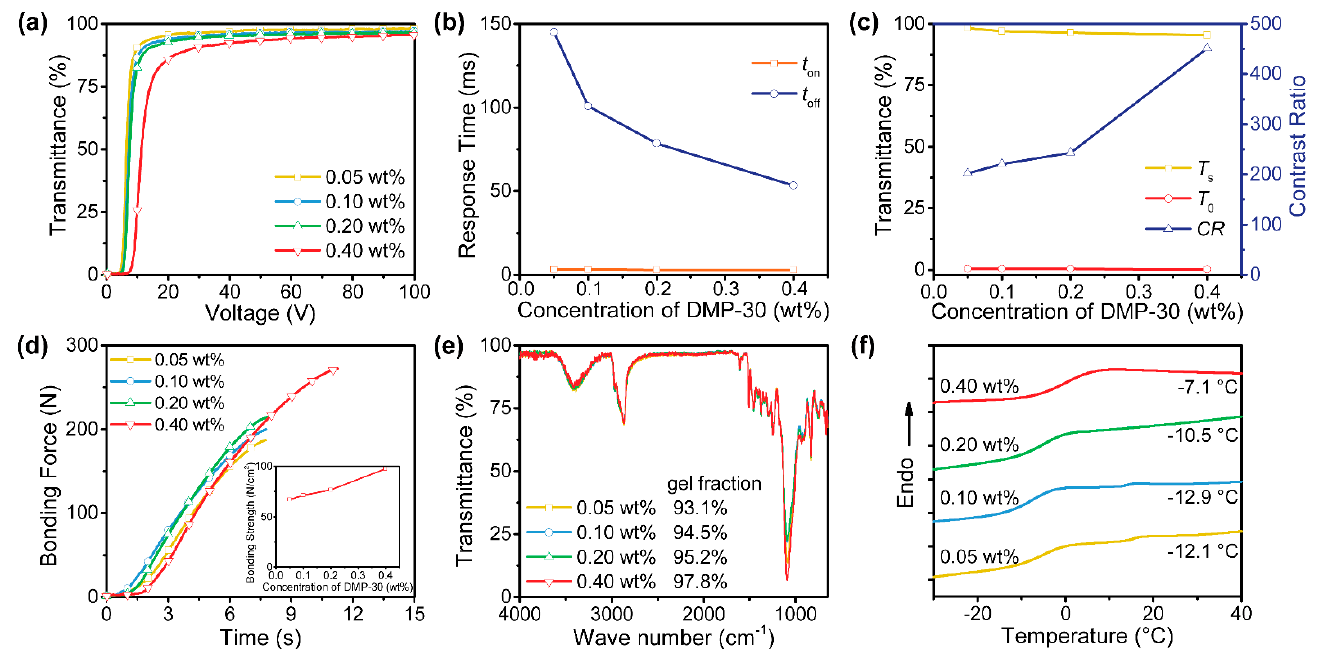
Figure 6. ( a ) The voltage dependence of the transmittance, ( b ) the response time, ( c ) the saturation transmittance, off-state transmittance, contrast ratios, and ( d ) adhesion strength of samples C1–C4; ( e ) FTIR spectra and gel fractions and ( f ) DSC thermographs of the polymer matrix of samples C1–C4.